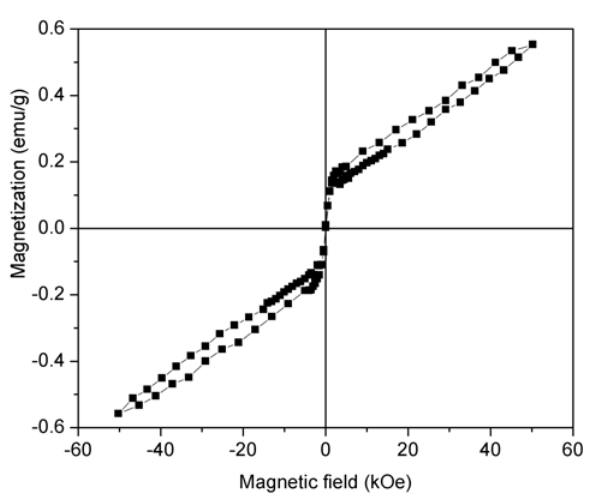
Figure 5 – M(H) curves of the sample prepared without using NaOH Рис . 5 – M(H) кривые образца , подготовленного без NaOH Слика 5 – M(H) криве узорка припремљеног без